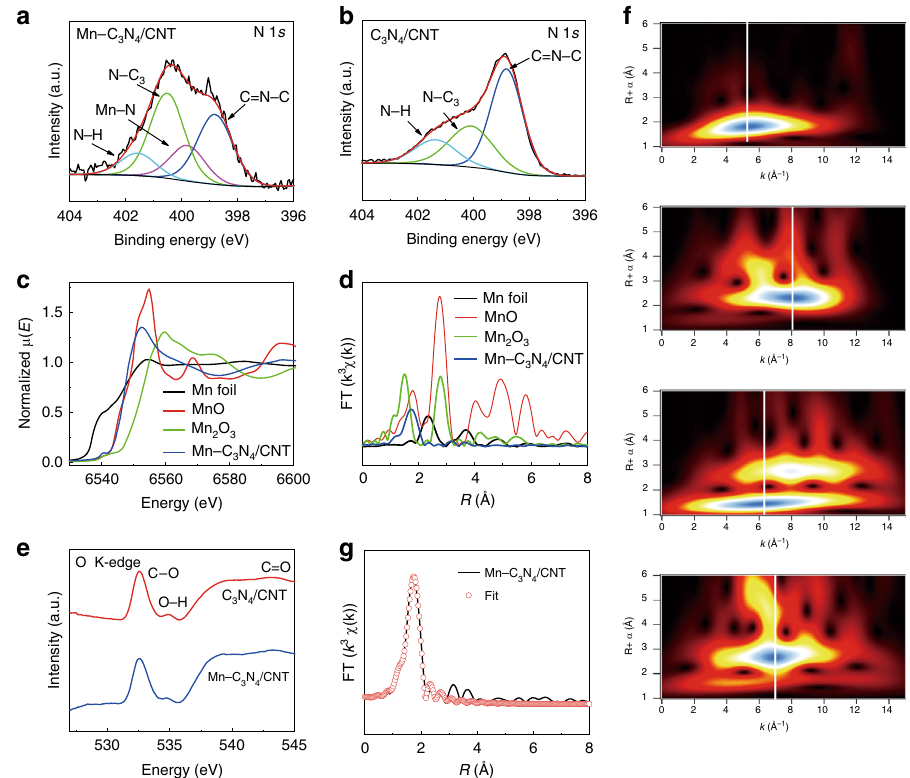
Fig. 2 Fine structure of Mn – C 3 N 4 /CNT. a , b High-resolution N 1 s XPS spectra of Mn – C 3 N 4 /CNT and C 3 N 4 /CNT, respectively. c , d XANES and EXAFS spectra at the Mn K-edge. e O K-edge XAS of Mn – C 3 N 4 /CNT and C 3 N 4 /CNT. f WT of Mn – C 3 N 4 /CNT, Mn foil, Mn 2 O 3 , and MnO (from top to bottom). g EXAFS fi tting curves of Mn – C 3 N 4 /CNT in R space. ascribed to the scattering path of Mn – N 18 . The wavelet transform (Fig. 2f). Quantitative EXAFS curve fi tting analysis (Fig. 2g and Supplementary Table 1) was performed to investigate the struc- tural parameters of Mn – C 3 N 4 /CNT, and the best- fi tting analysis clearly con fi rms that the Mn – N coordination number is ~3.2, meaning that the isolated Mn atom is threefold coordinated by NATURE COMMUNICATIONS| (2020) 11:4341